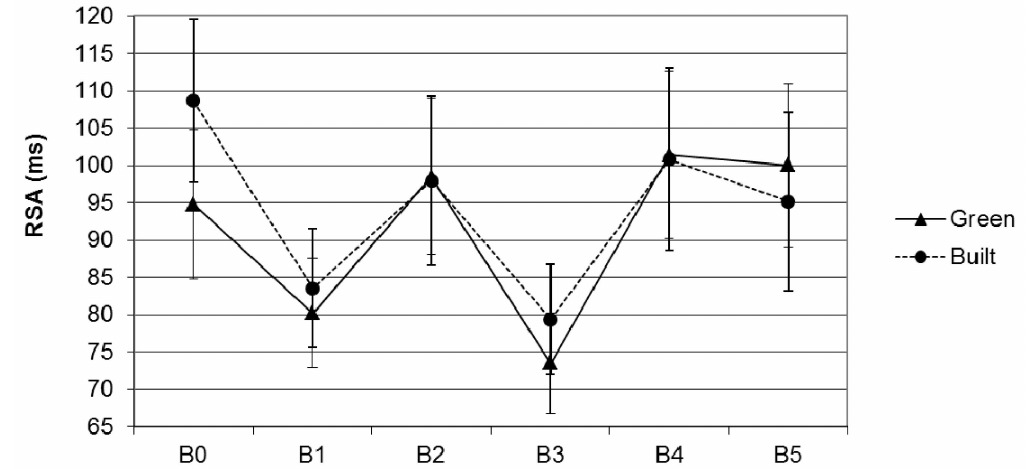
Figure 3. Unadjusted mean RSA during the first six blocks in the green and built condition. B0 = Baseline 1; B1 = MIST control; B2 = photo viewing 1; B3= MIST stress; B4 = photo viewing 2, B5 = baseline 2; error bars represent standard errors of the